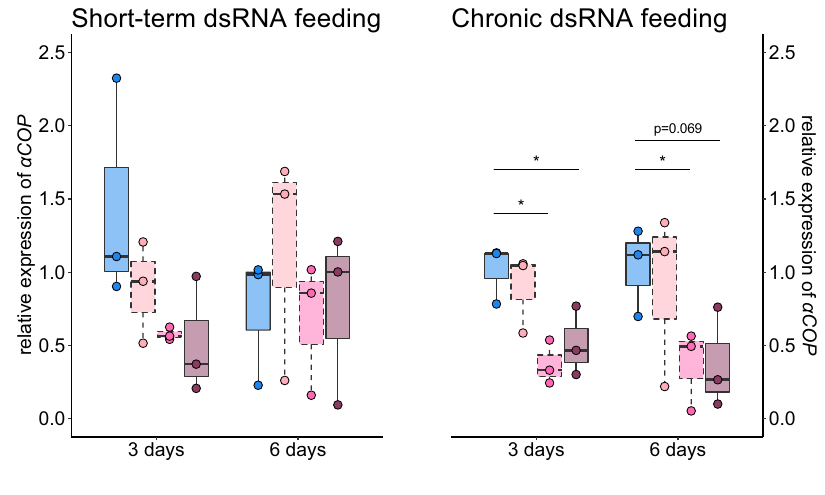
Fig. 2 Results of gene expression analysis via quantitative polymerase chain reaction (qPCR) showing relative expression of α COP in Brassicogethes aeneus at 3 and 6 days after the start of the experiment ( n = 3 biologically independent qPCR samples per treatment and time point). Target treatments (ds α COP at 0.5, 2.5 and 5 µ g/ µ L) are statistically compared to the dsGFP 5 µ g/ µ L (control) treatment. Asterisk ( * ) indicates a signi fi cant difference ( p ≤ 0.05) between treatments. Analysed using Welch ’ s t